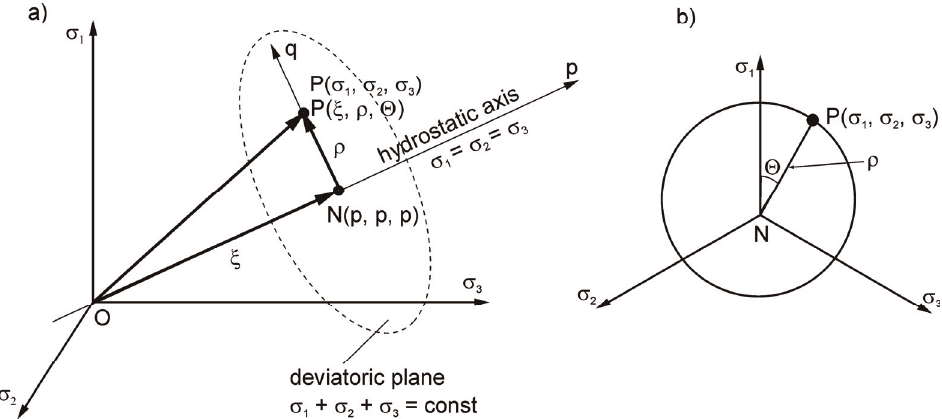
Fig. 2. The state of tension in the principal stress in the Cartesian coordinate system (a) and the deviatoric plane (b)